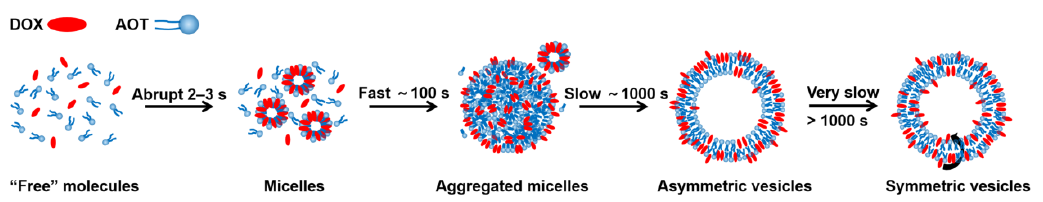
Figure 13. Proposed mechanism of the vesicle formation in DOX/AOT mixed solutions. Reproduced with permission [47]. Copyright 2022 Royal Society of Chemistry.